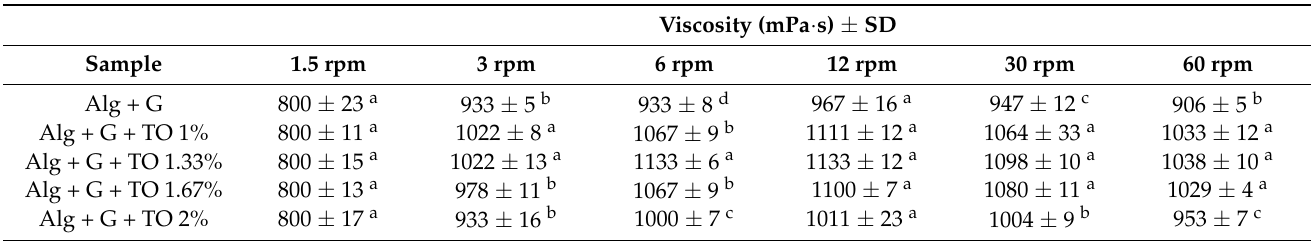
Table 1. Viscosities (mPa · s) of alginate solutions with glycerol and tansy essential oil at different speeds (1.5–60 rpm); SD means standard deviation.